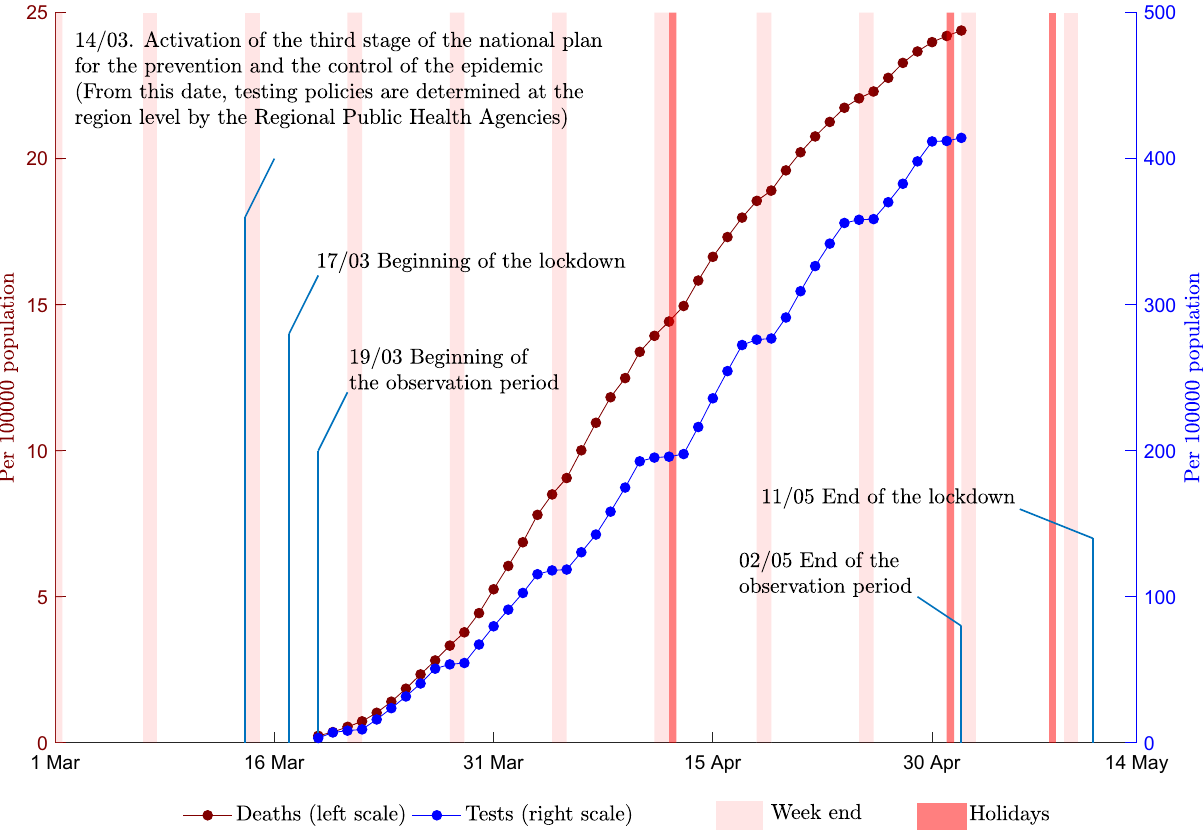
Figure 1. Cumulated number of SARS-CoV2 tests and deaths related to COVID-19, France, March–May 2020. Number of tests and deaths are expressed for 100,000 inhabitants. The cumulated number of deaths are those observed in hospitals during the study period. The cumulated number of tests are the RT-PCR tests performed in non-hospital laboratories during the study